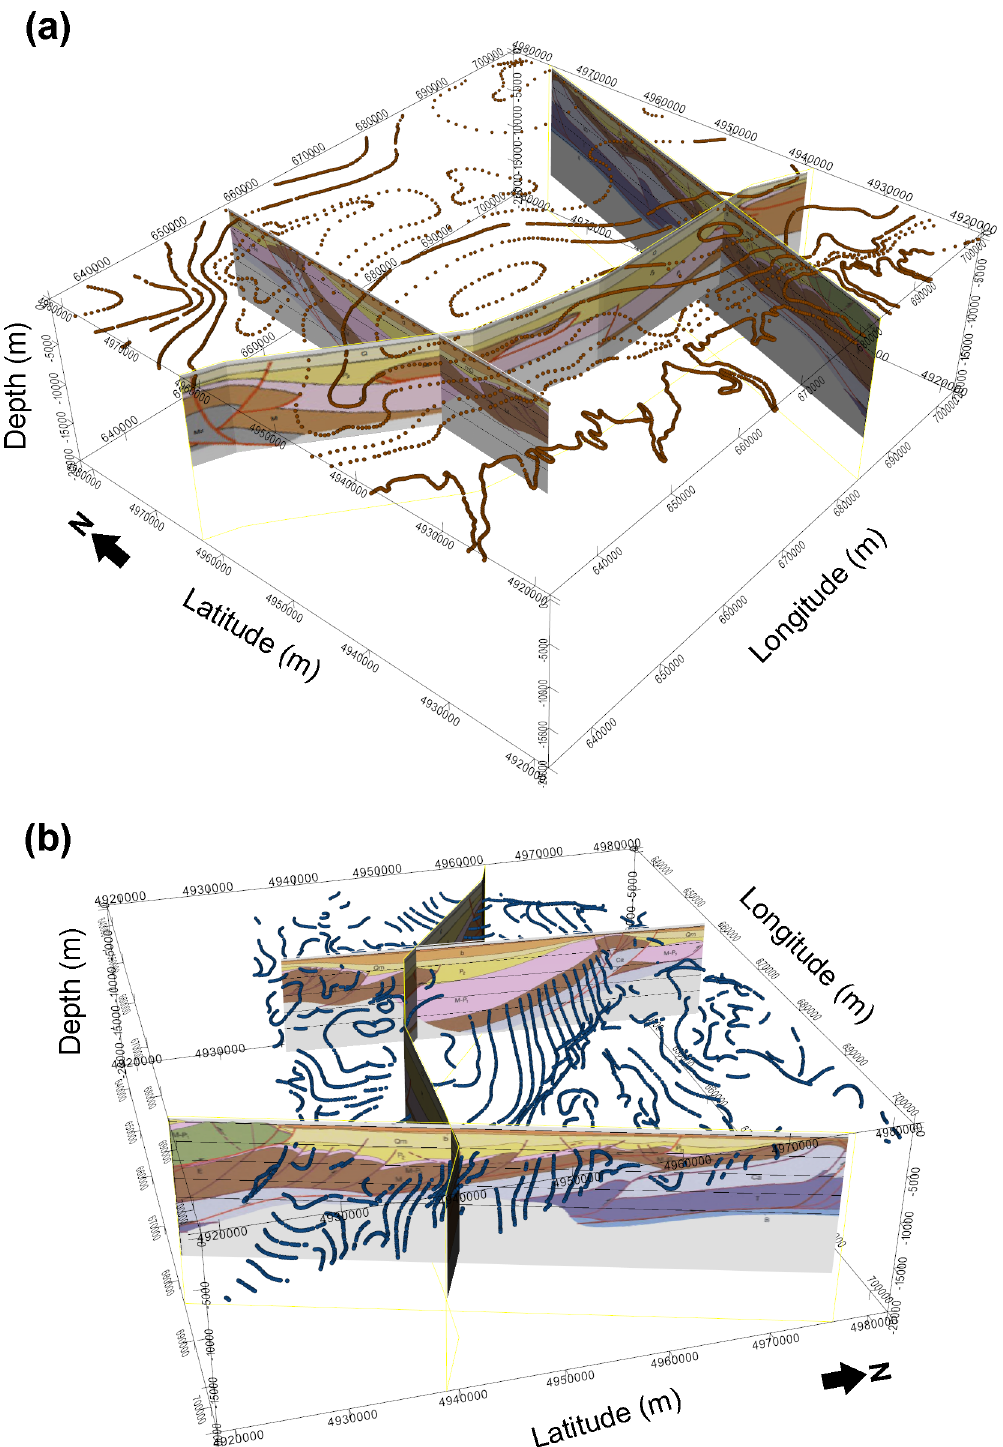
Figure 3. Geological cross-sections and 3-D surfaces. (a) Southwest view and base of the plain deposits (Formation A); (b) east view and base of the Late Pliocene (Formation